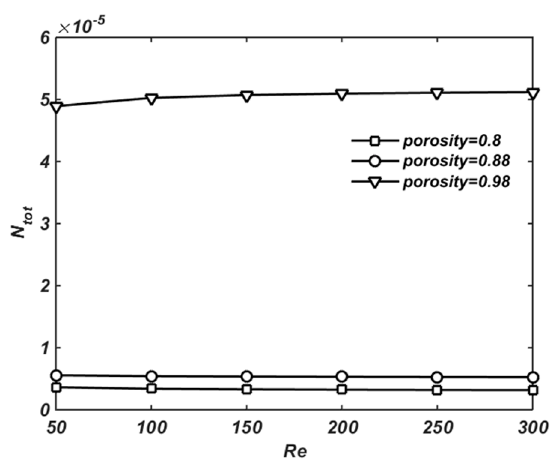
= Figure 10. N(cid:3368) (cid:3047)(cid:3042)(cid:3047) as a function of Re in different values of porosity ε . Figure 10. N tot as a function of Re in di ff erent values of porosity ε